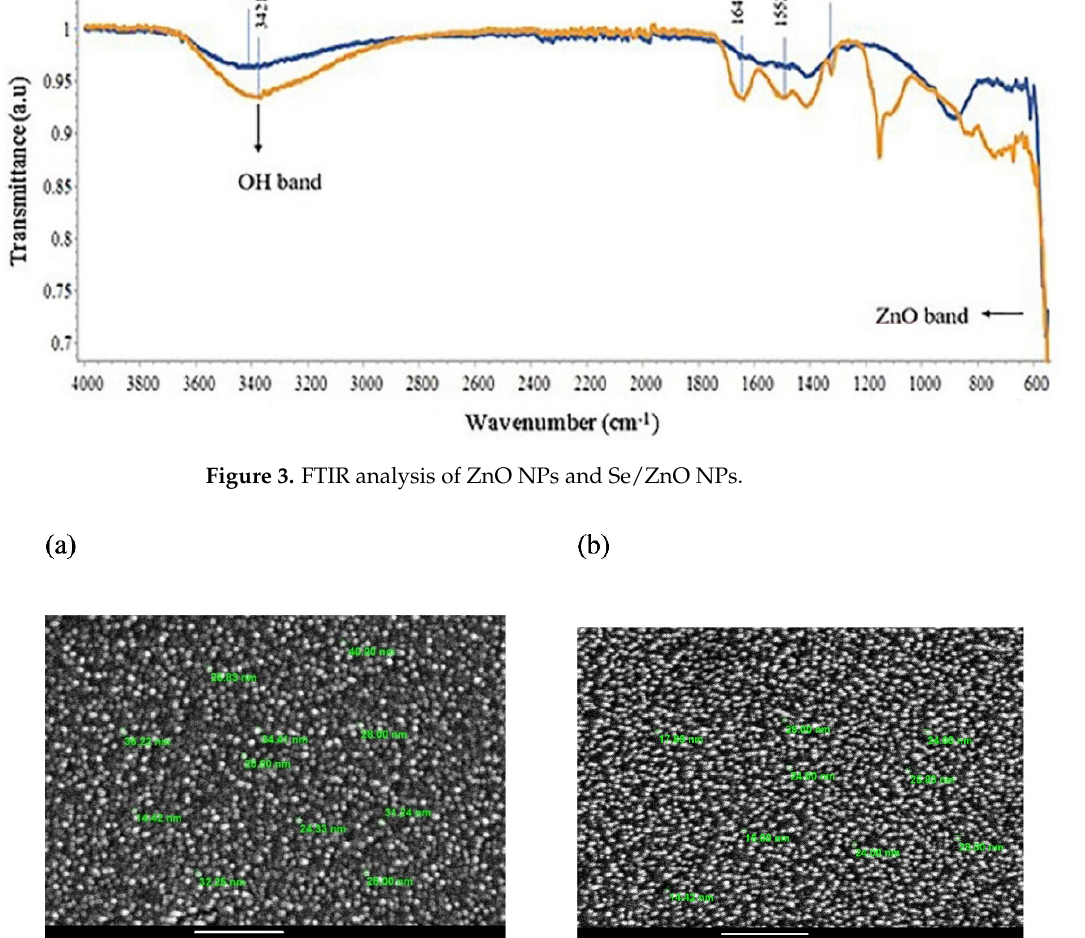
Figure 3. FTIR analysis of ZnO NPs and Se/ZnO NPs.